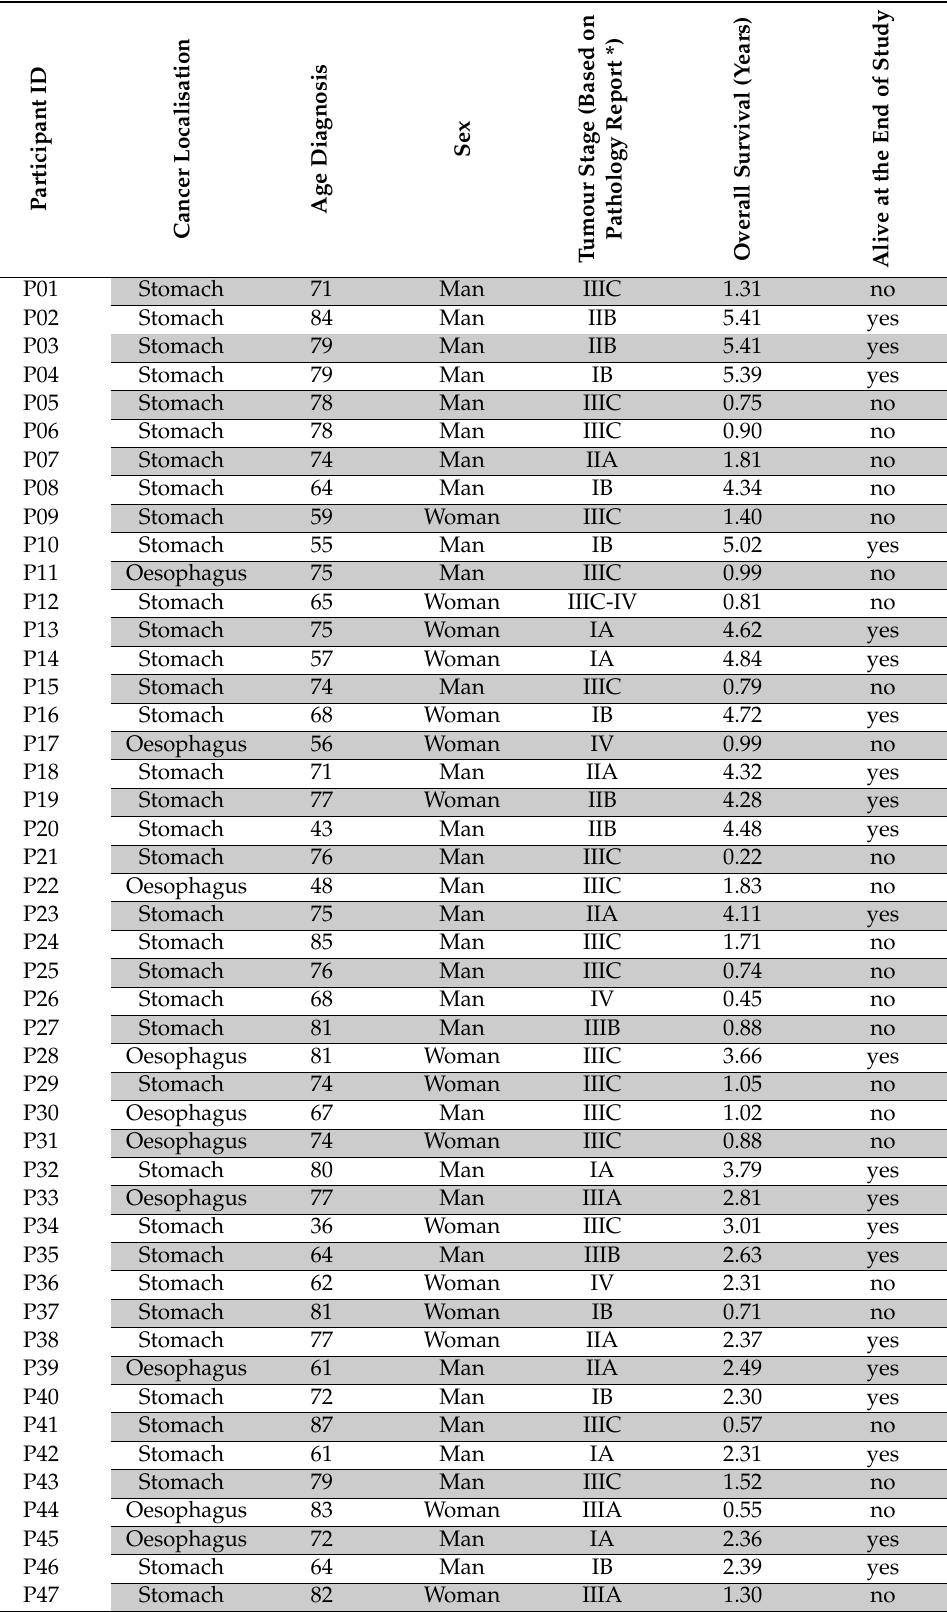
Table 1 Legend: The table states clinical data from each participant. Further clinical details can be seen in Table S4. * As reported by the Pathology Department, Karolinska University Hospital, Stockholm, Sweden. Analysis performed on clinical tumour tissue